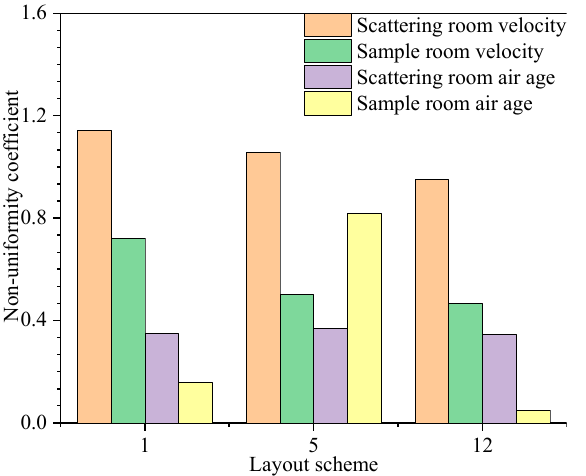
Figure 9. Comparison of non-uniformity coefficient of three layout schemes (The scattering room z = 1.6 m and the sample room z = 2.4 m).